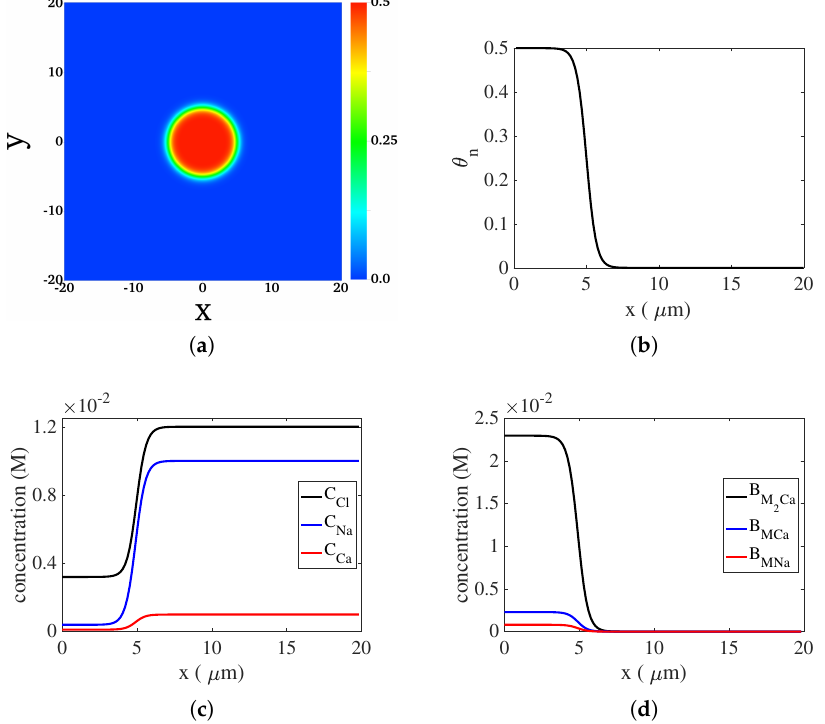
Figure 1. The two-dimensional computational domain and the initial distributions of model variables. ( a ) Initial distribution of θ n . ( b ) Profile of θ n at t = 0 along the positive x -axis. ( c ) Profiles of the concentrations for dissolved ions at t = 0 along the positive x -axis. ( d ) Profiles of the concentrations of bound ions at t = 0 along the positive x